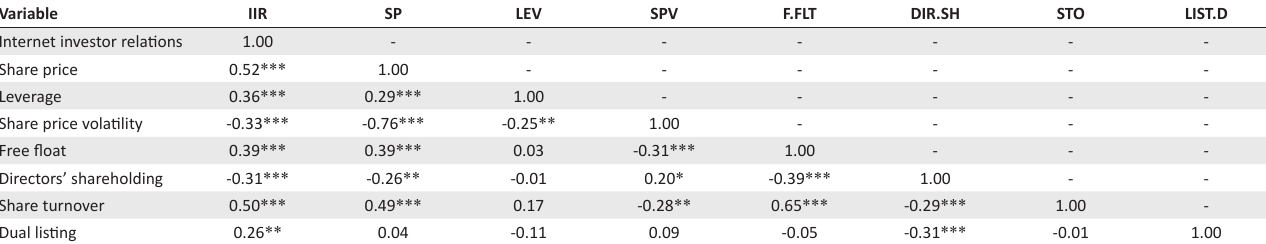
TABLE 5: Correlation matrix: Independent variables.